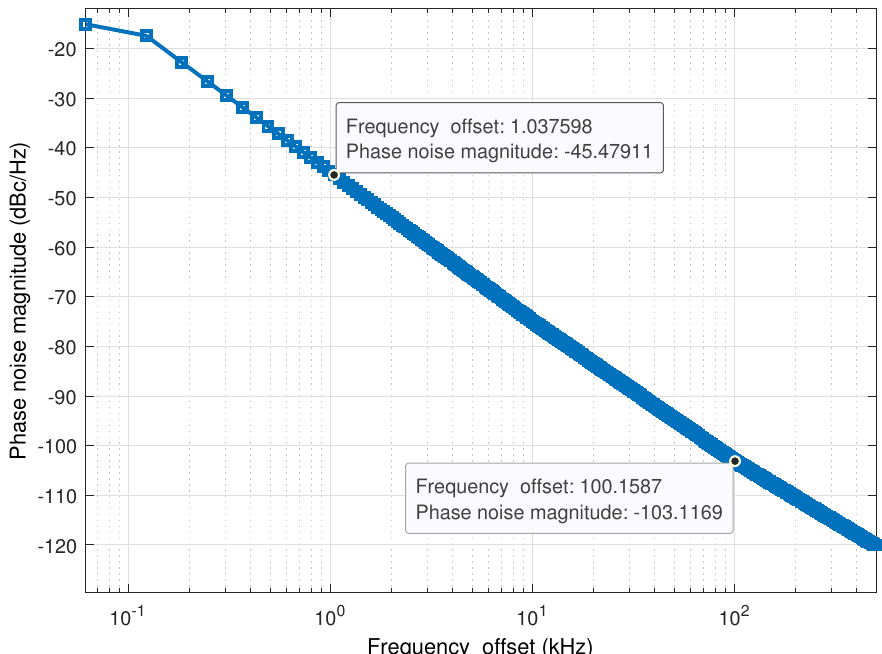
Figure 15. Phase noise model for 2.4 GHz CMOS